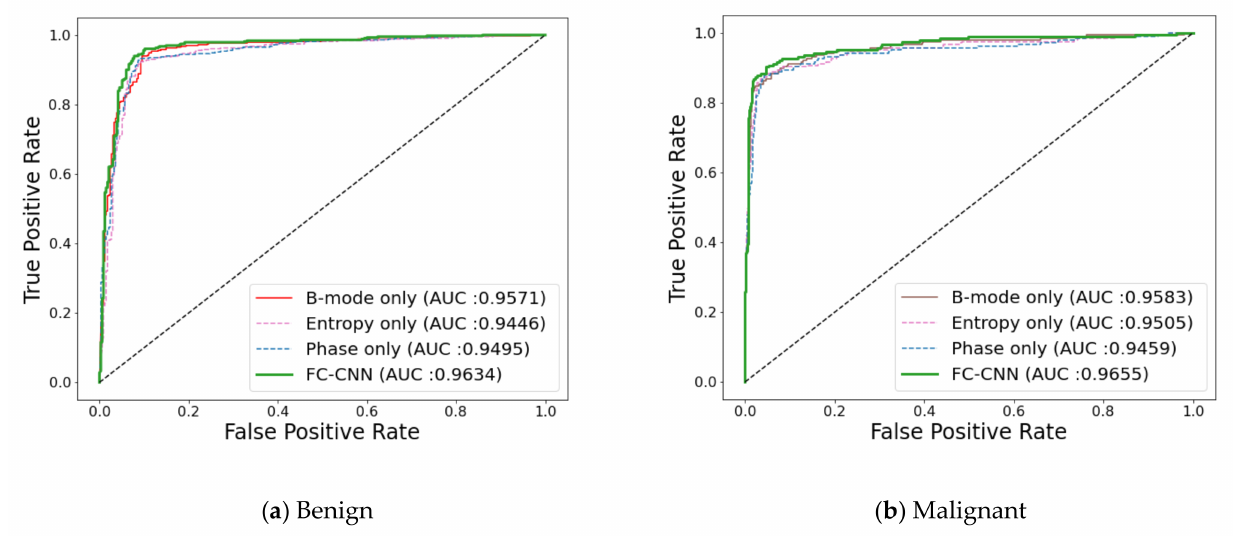
Figure 5. The ROC Curves of the traditional CNN and the FC-CNN architectures for ResNet-34; ( a ) benign, ( b )